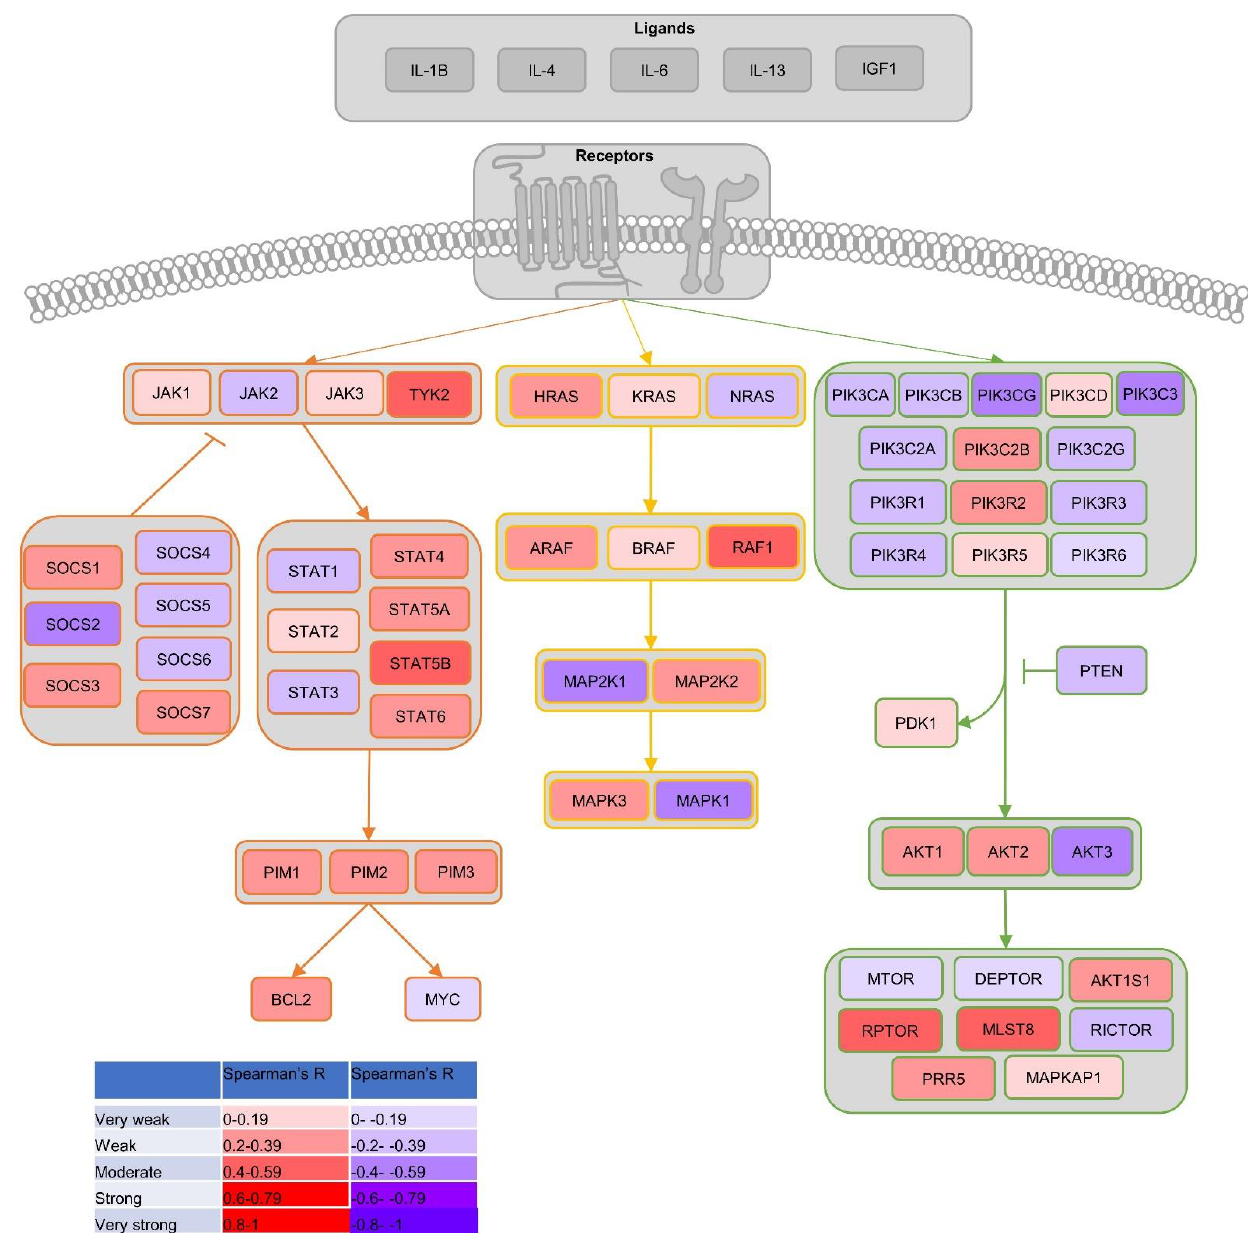
Figure 5. An overview of BRD9 correlation with common signalling pathways involved in PCa. Flowchart signalling pathway diagram/heatmap showing mean significant Spearman’s R BRD9 correlation from datasets with genes in the JAK-STAT, MAPK and PI3K-AKT-mTOR signalling pathways. Adapted and expanded from Luzczak et al’s Figure 2 [57]. Image created using Microsoft PowerPoint.